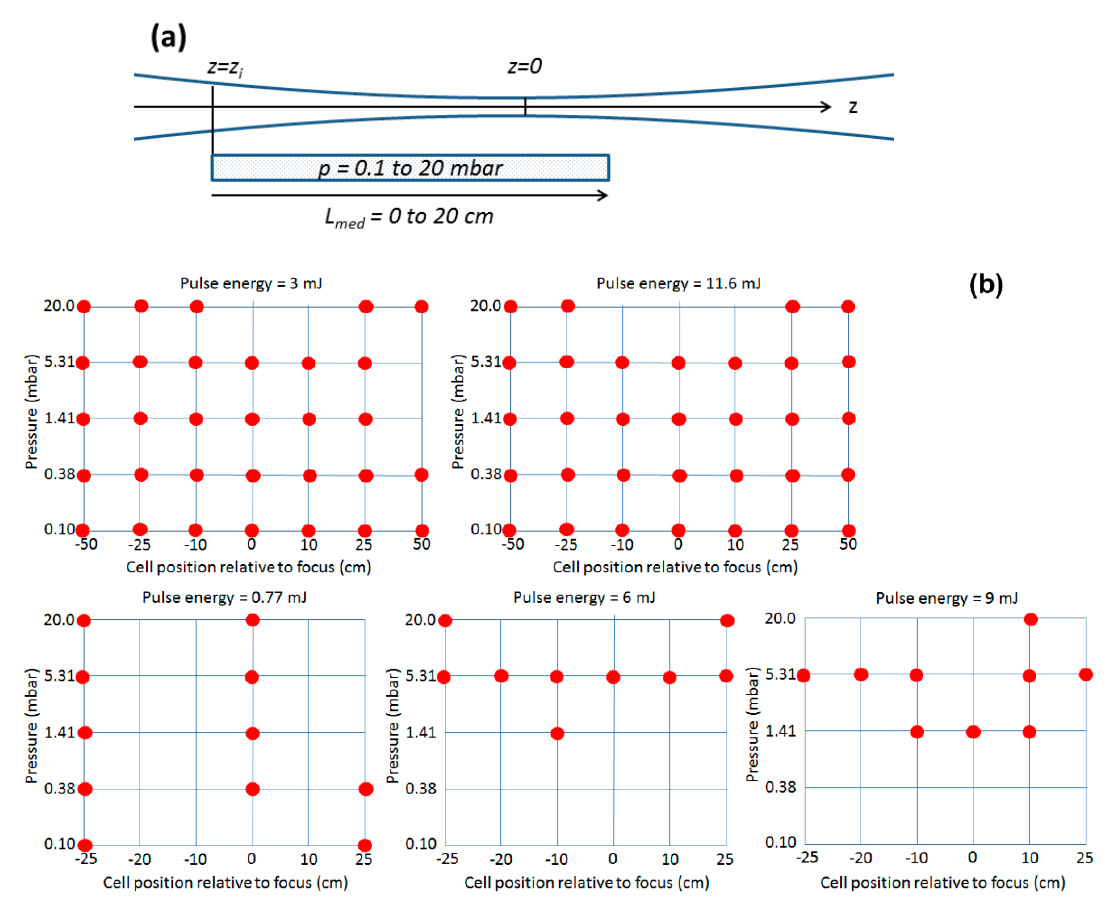
Figure 3. ( a ) Sketch of the geometrical arrangement: laser pulse propagates from left to right; interaction cell filled with gas at p pressure, begins at z i position relative to focus; L med is the length of the interaction medium. ( b ) Schematic representation of the parameter space where the full 3D calculations have been performed. For each pulse energy full 3D calculations were performed for several cell positions relative to focus (x axis) and gas pressures (y axis). Red bullets represent the particular cases solved by full 3D simulations and used by ANN for training, validation and testing.